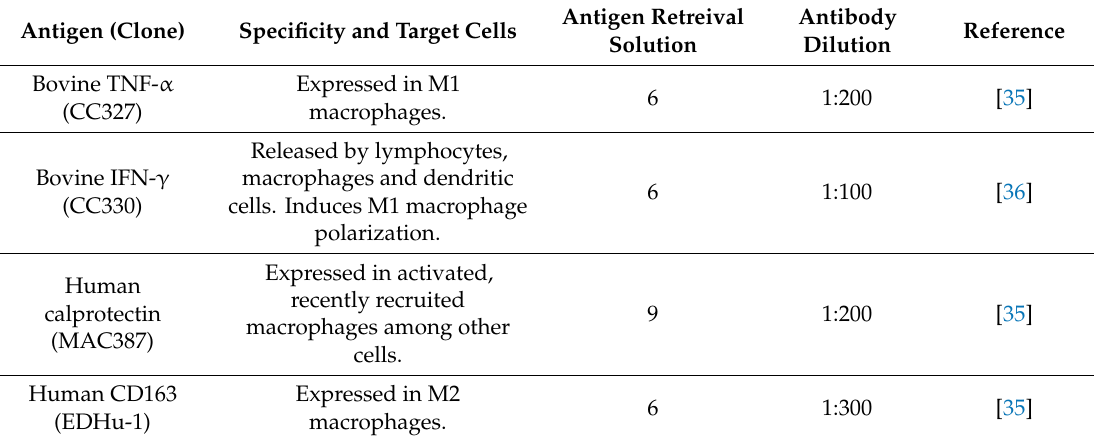
Table 1. Immune markers detected in the immunohistochemistry